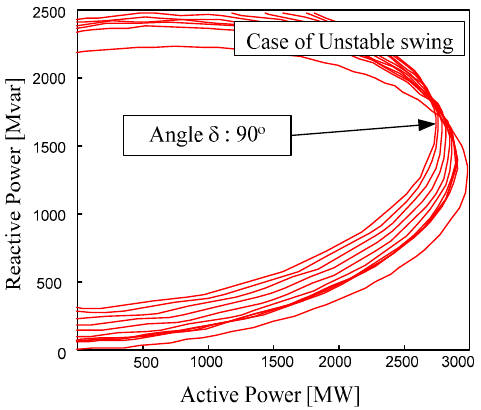
Figure 13. The trajectory of complex power in a complex plane (the fault clearing time is 15 cycles).